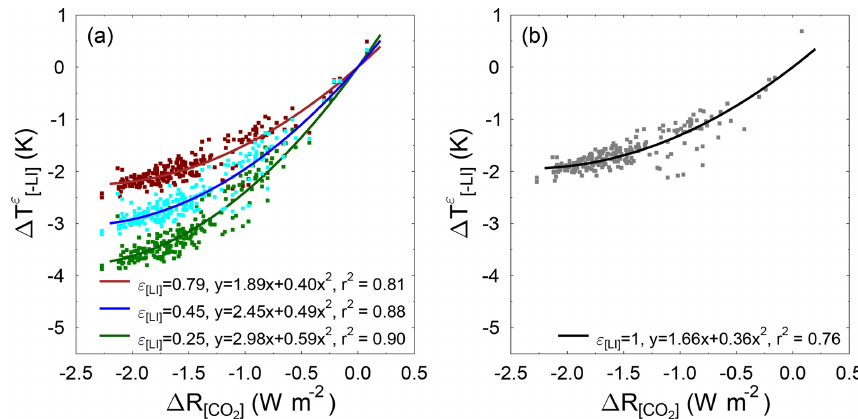
) calculated using Eq. (16) against LI ]